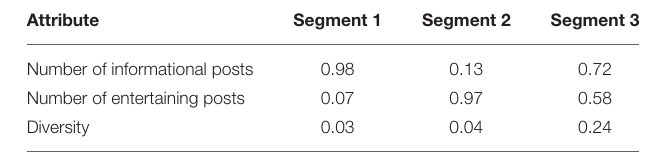
TABLE 1 | Measure and performance of SVM. TABLE 2 | Centers of three clusters.